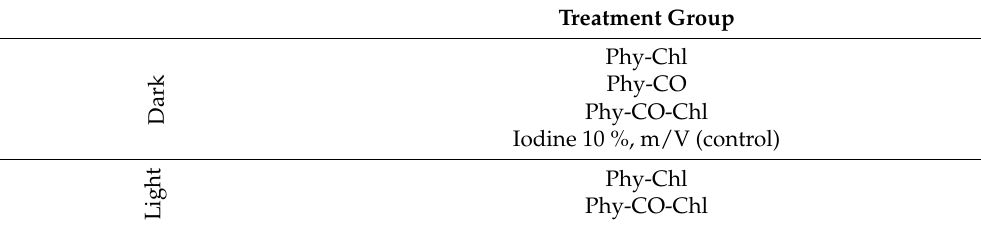
Table 2. Rabbits’ treatment groups.